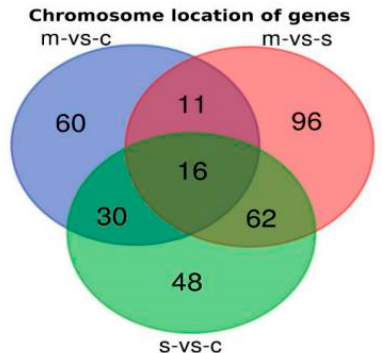
Figure 2. DEGs chromosomal location intersection between the three gene sets for moderate (m), severe (S), and moderate-to-severe asthma.